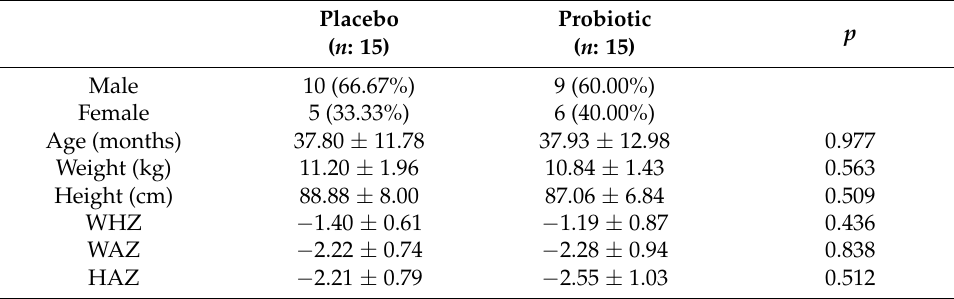
Figure 2. CONSORT diagram of subject participation during the study. Table 2. Characteristics of the study subjects.